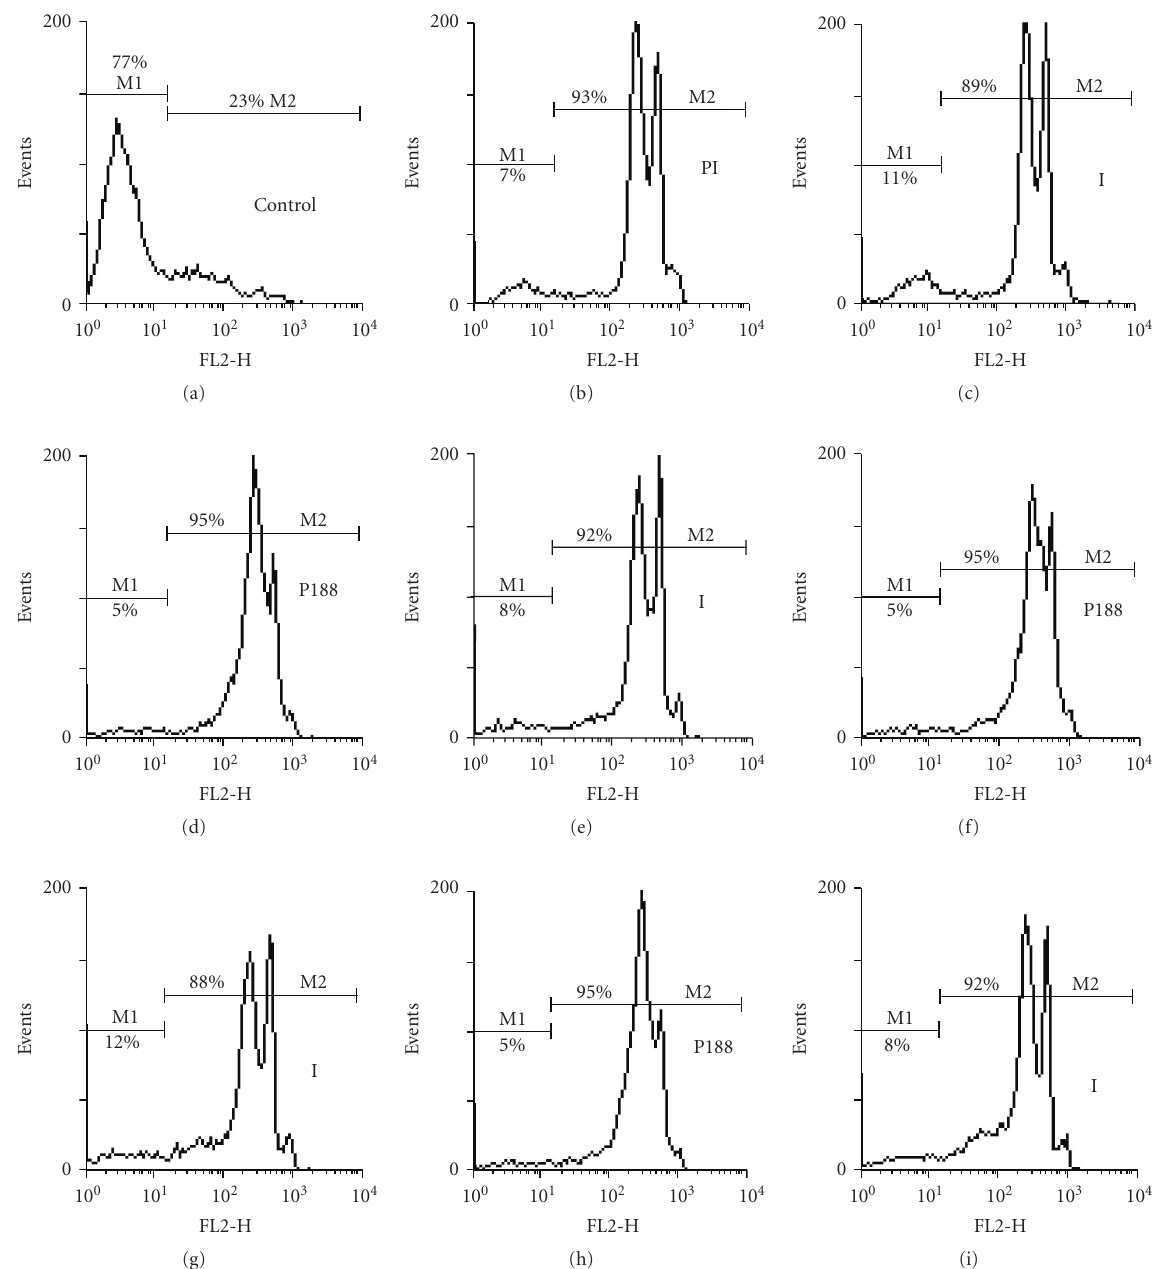
Figure 2: Flow cytometry of MDA-MB-231 cells. Experimental conditions: 5 · 10 5 cells per 100 μ l suspension of 0.3 M mannitol, 0.1 mM Ca acetate and 0.1 mM Mg acetate. Field strength—1.0 kV · cm − 1 , one pulse with a duration of 5ms. 100 μ M propidium iodide (PI) was added during the pulse or after it; (a) nonporated control with PI added; (b) porated control with PI added before the pulse; (c) porated control with PI added after the pulse; (d) and (e) 0.1 mM, (f) and (g) 0.5mM, (h) and (i) 1.0 mM poloxamer 188 and 100 μ M PI added; (d), (f) and (h) are samples electroporated in the presence of poloxamer 188 and PI; (e), (g) and (i) poloxamer 188 and PI were added after the pulse. The M1-marker represents the nonpermeable cells and the M2-marker—the permeable